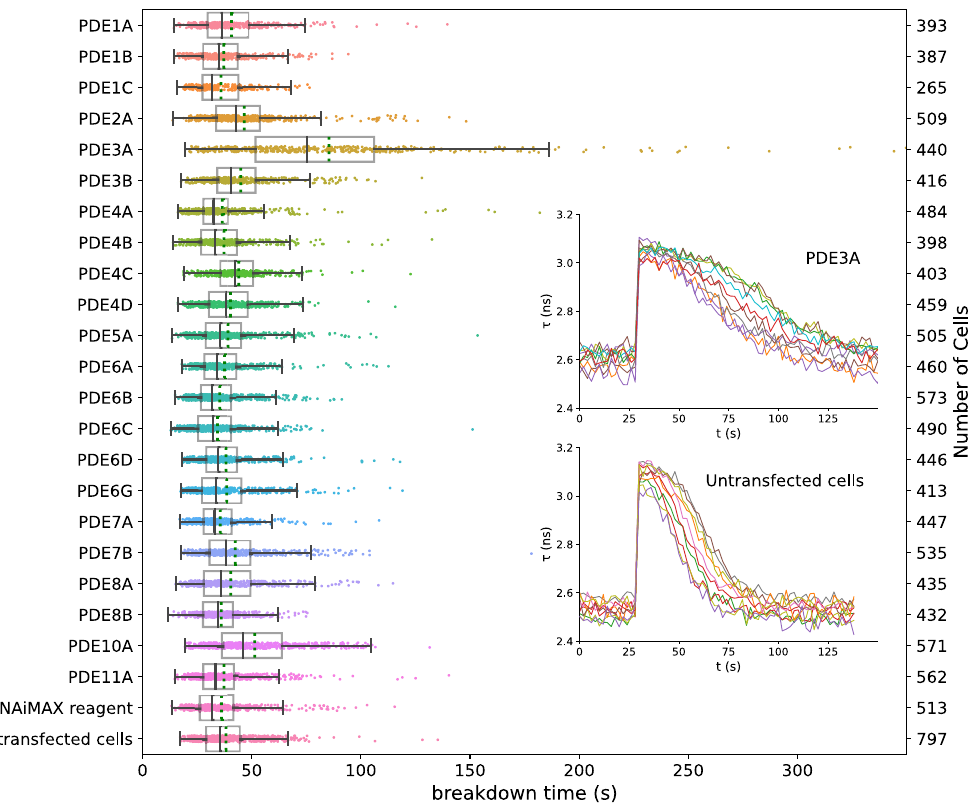
Figure 4. Decay time of donor lifetime signals following UV-uncaging of cAMP in cells treated with siRNAs for the indicated PDEs. Note significantly slower breakdown upon knockdown of PDE3A, and a smaller, but still significant contribution of PDE10A. Datapoints are fitted decay times of single cells. For each condition, the experiment was performed in duplicates, with cells grown, transfected, and assayed in two independent wells. Indicated are median value (vertical black line), mean value (green dotted line); boxes encompass middle 50% of values and whiskers represent 1.5 times the interquartile range. Inset: 10 representative traces for cAMP decay in